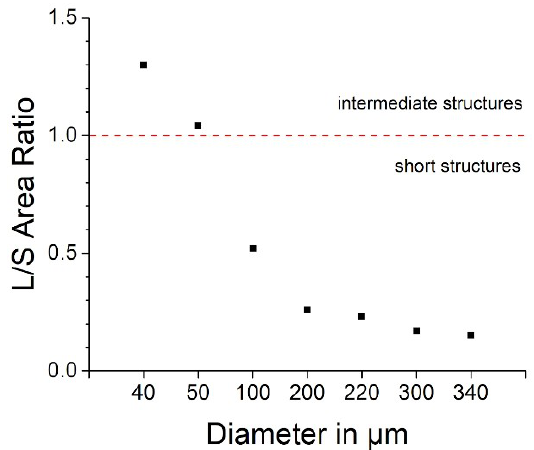
Figure 4. Lateral/surface area ratio calculated for not-pyrolyzed SU-8 cylindrical test structures with different diameters (ranging from 40 to 340 μm) and with a height of 13 μm before pyrolysis.